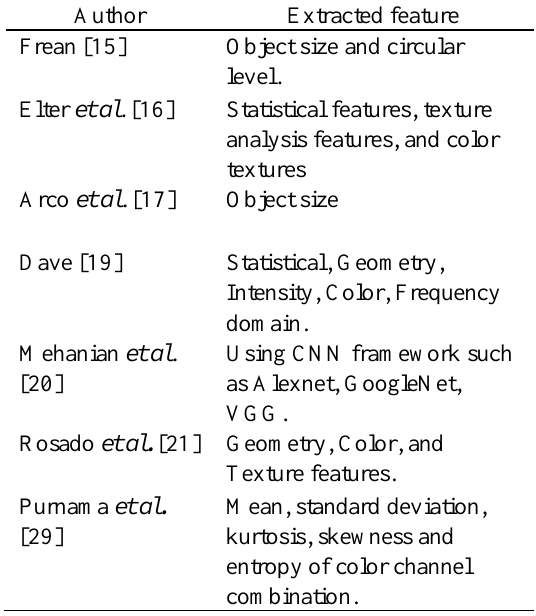
Table 3. Summary of extracted